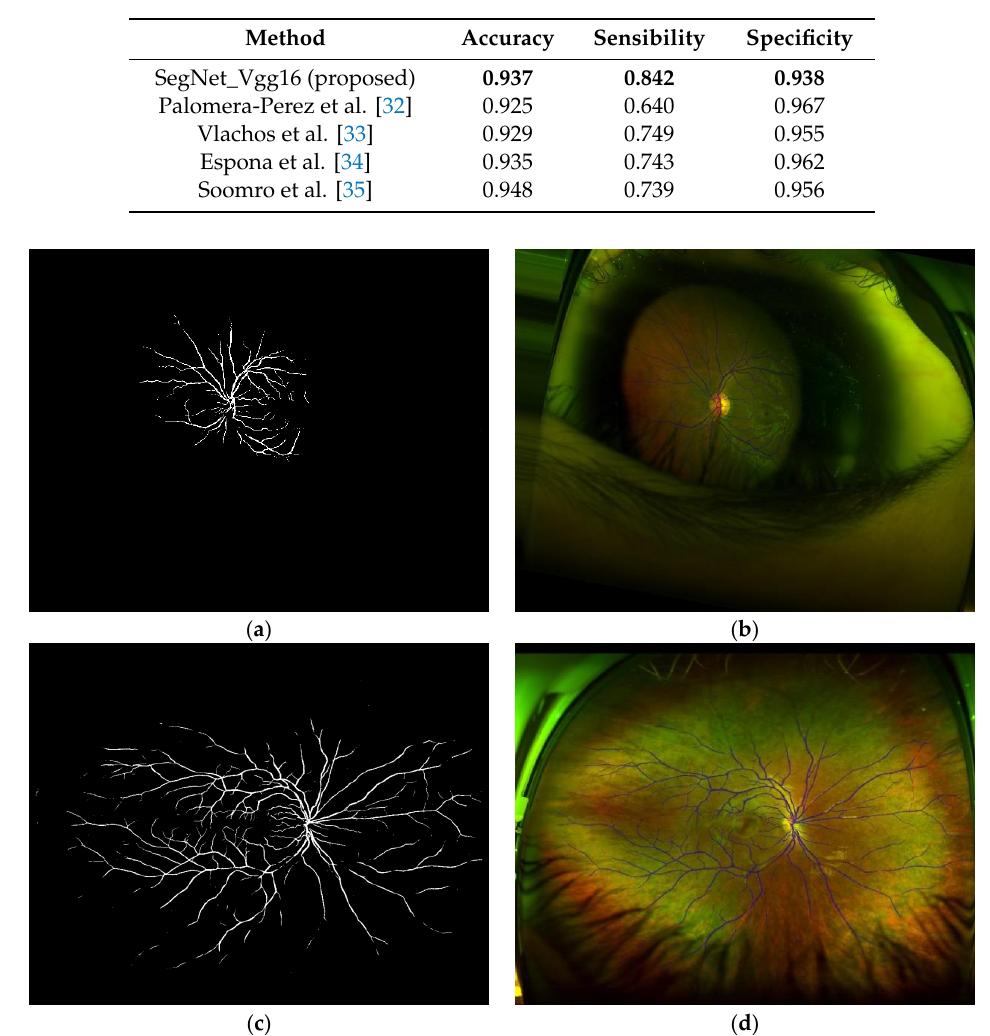
Table 7. Performance comparison for the vessel segmentation using DRIVE.